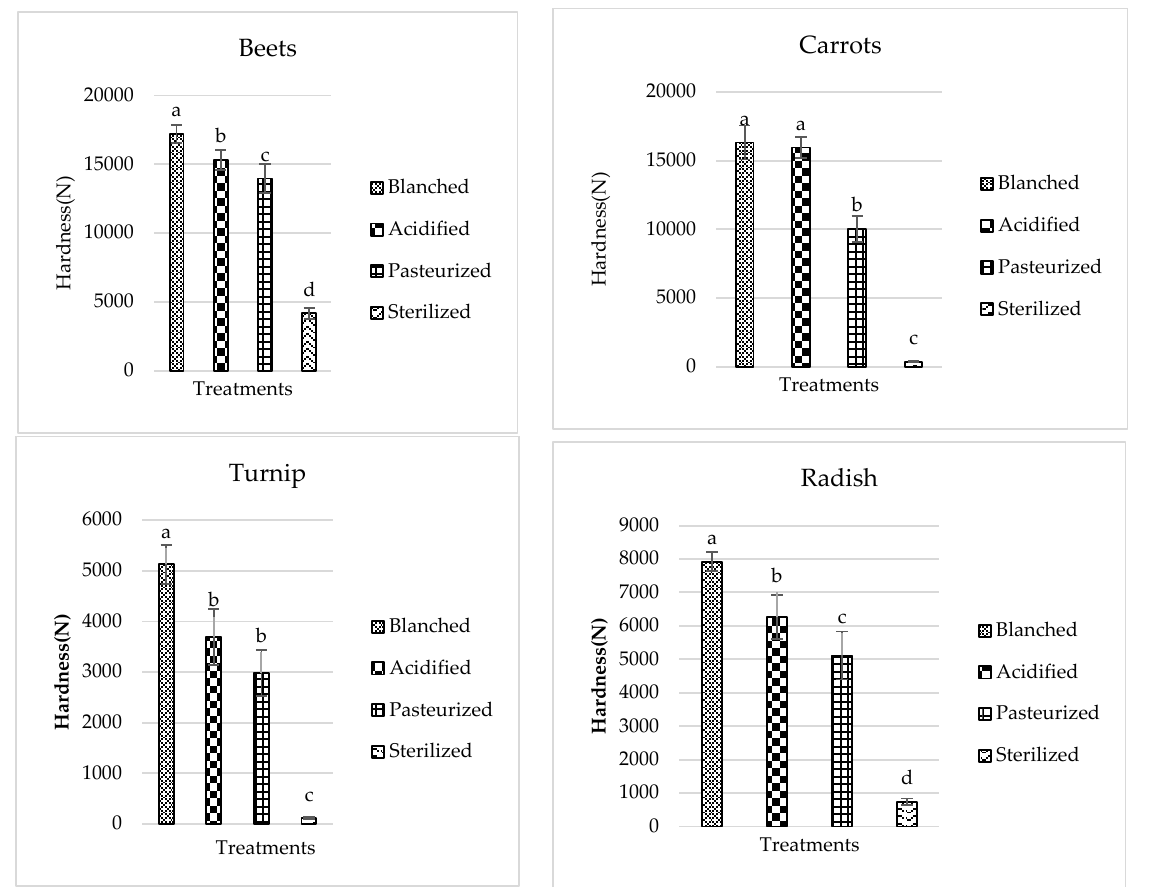
Figure 3. Hardness of evaluated vegetables at different unit operations including pasteurization and sterilization processes. Different letters indicate a significant difference ( p < 0.05).